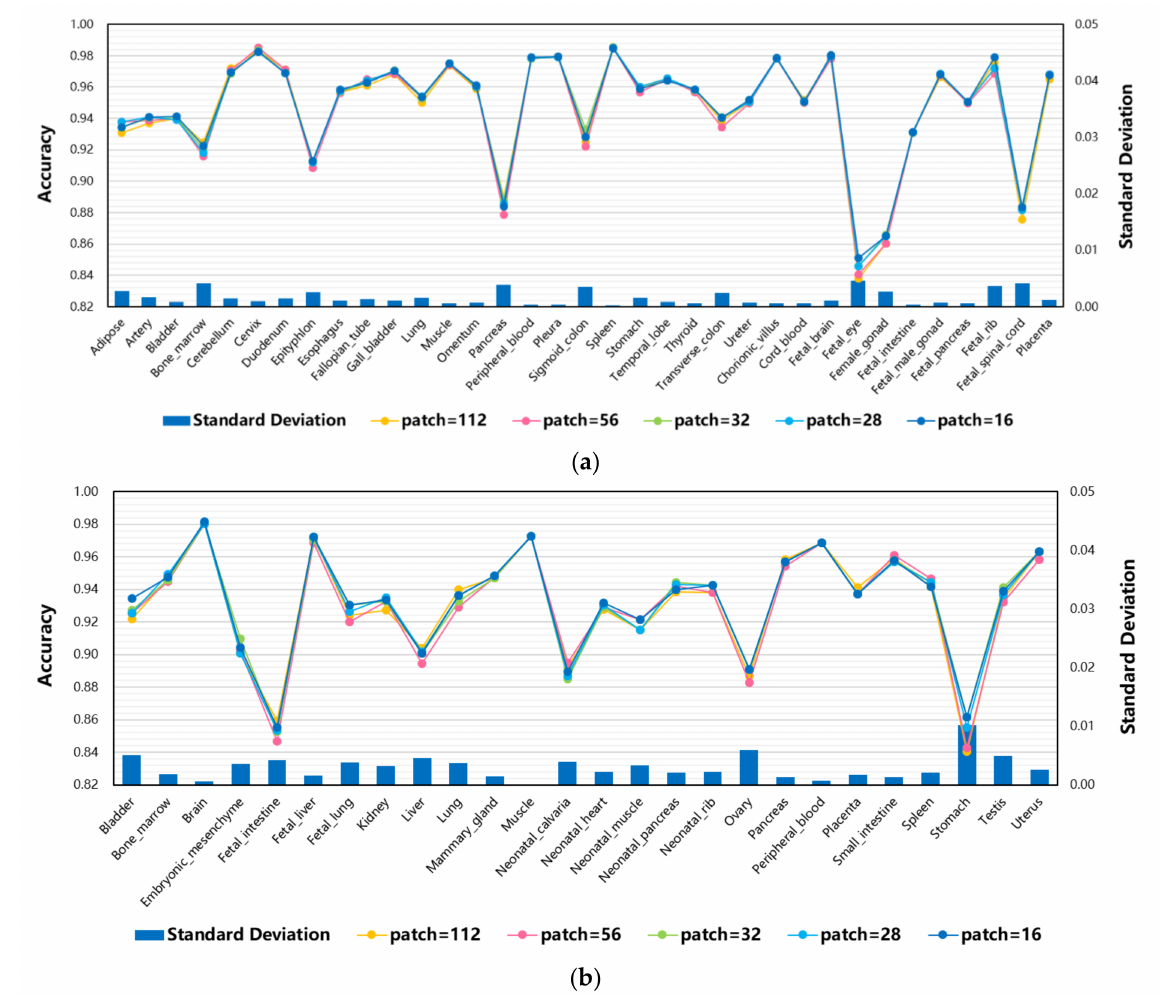
Figure 8. Performance of scTransSort at different patch parameter settings. ( a ) Experiments on cells containing 35 human tissues; ( b ) Experiments on cells containing 26 mouse tissues. The line chart shows the accuracy of cell classification predictions for each group of data under different model parameter settings (patch size). Each color line represents a specific parameter setting. The bar chart displays the standard deviation of the results obtained with different patch parameter